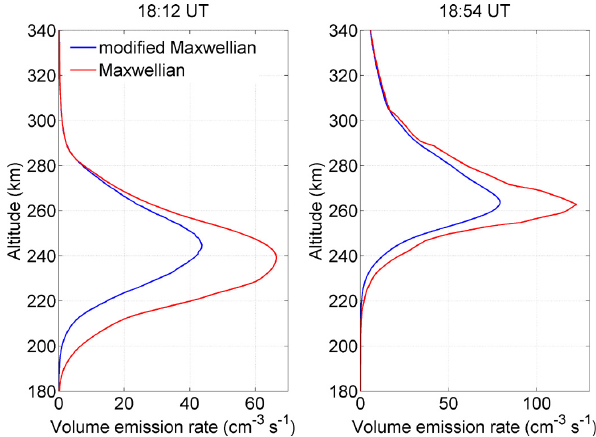
Fig. 4. The altitude profile of the 630.0nm volume emission rate. The blue line corresponds to the electron flux calculated with the transport model. The red line shows the calculated result with a Maxwellian flux of the ionospheric